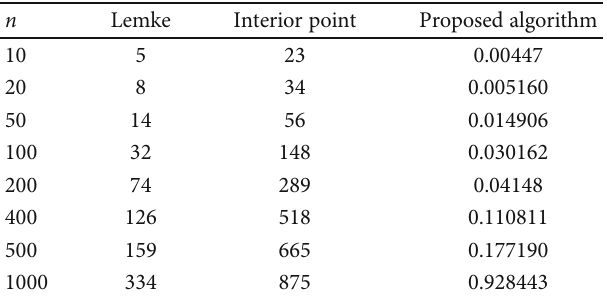
Figure 2: Comparison between our method with the method of El foutayeni, the method of Yu, and the method of CHKS as a function of time and number of iterations in the case where n = 8 . Table 5: The execution time for the di ff erent